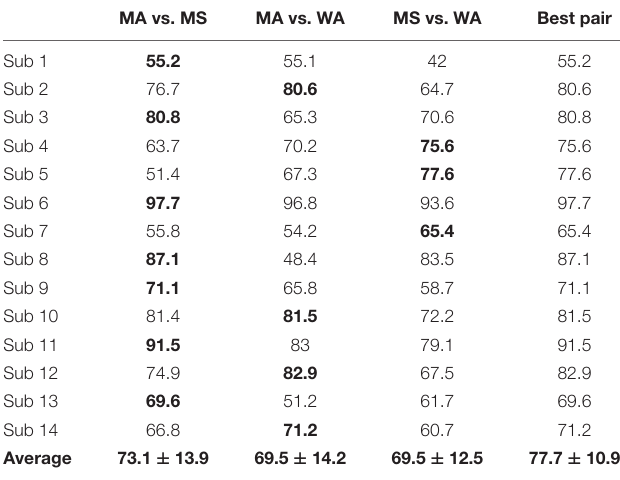
TABLE 1 | Classification accuracies (%) of each pair of mental tasks for each subject in the offline experiment. The bold-font indicates the classification accuracies for the best pair of mental tasks for each subject. MA vs. MS